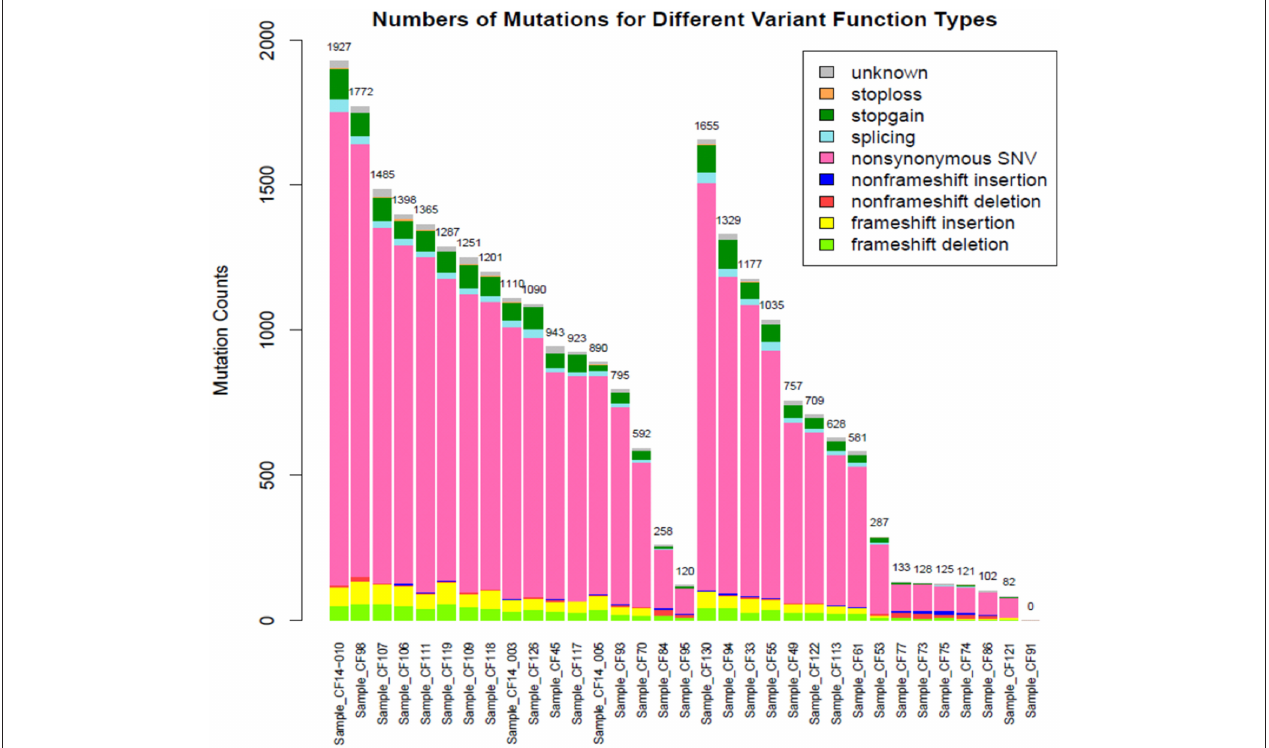
FIGURE 2 | Number of mutations for different functional types for the cancer (left) and control (right) groups.